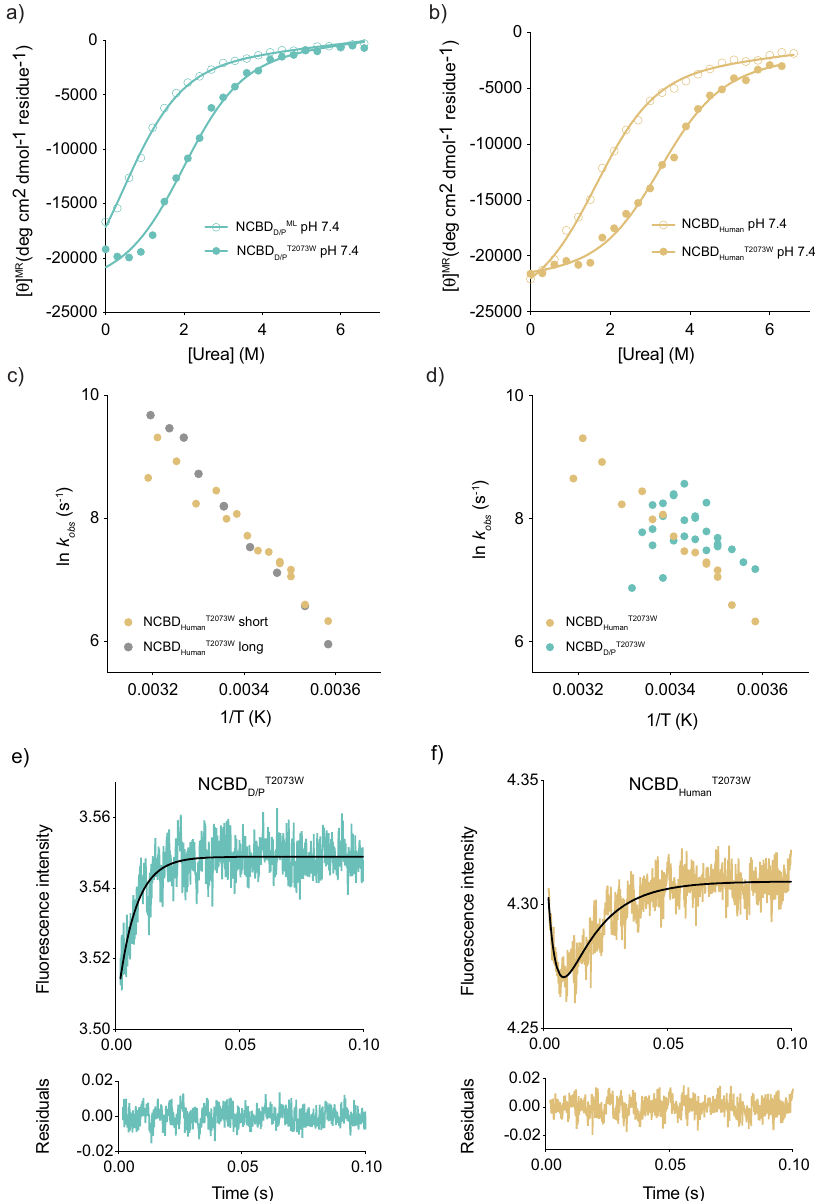
Fig. 6 Thermodynamic stability and temperature dependence of kinetic rate constants for NCBD D/P ML and extant NCBD Human . a Stability measurement of NCBD D/P ML (open circles) and NCBD D/P T2073W ( fi lled circles) measured by urea denaturation. b Stability measurement of NCBD Human WT (open circles) and NCBD Human T2073W ( fi lled circles). Parameters from the curve fi tting are shown in Table S2. c Temperature jump kinetic experiments for a longer human NCBD construct used in previous studies 24 (gray) and the shorter human NCBD variant used in this study (gold). Both variants contained the T2073W mutation. d A comparison of observed rate constants from temperature-jump experiments for NCBD Human T2073W (gold) and NCBD D/P T2073W (teal). All experiments were performed in 20 mM sodium phosphate pH 7.4, 150 mM NaCl. e , f Kinetic (un)folding of NCBD Human T2073W and NCBD D/ T2073W measured by stopped- fl ow fl uorescence spectroscopy. e Stopped- fl ow (un)folding kinetic transient of NCBD P exponential function (black line). f (Un)folding kinetic transient of NCBD Human T2073W (gold) fi tted to a double exponential function (black line). Below each transient are the residuals from the respective fi ts. The experiments were performed by jumping from 5 mM HCl (pH ∼ 2.3) to a fi nal buffer concentration of 20 mM sodium phosphate (pH 7.4), 150 mM NaCl, 1 M TMAO. The relaxation was monitored using a 330 band-pass emission fi lter. Fitting a double exponential function resulted in k obs values of 290 ± 30 and 67 ± 4 s − 1 for NCBD Human T2073W . Fitting a single exponential function yielded a k obs value of 139 ± 7 s − 1 for NCBD D/P T2073W